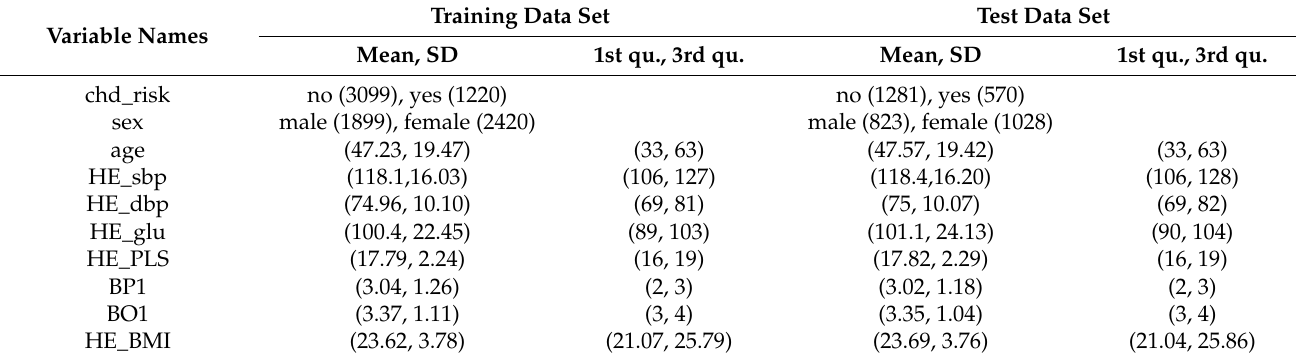
Table 2. Descriptive statistics of variables of training and test data